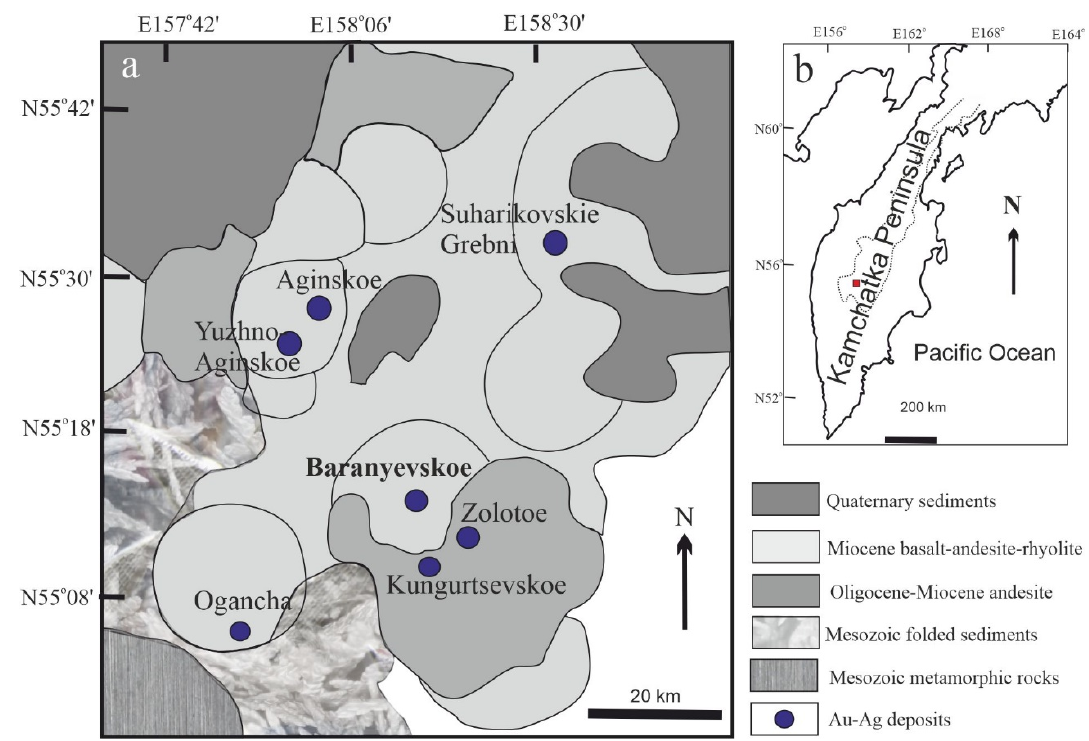
Figure 1. Location of the Au-Ag deposits on the geological map of the Central Kamchatka ore region modified after [18,26] ( a ) and their position on the Kamchatka Peninsula (red square) in the contours of the Central Kamchatka volcanic belt ( b ).